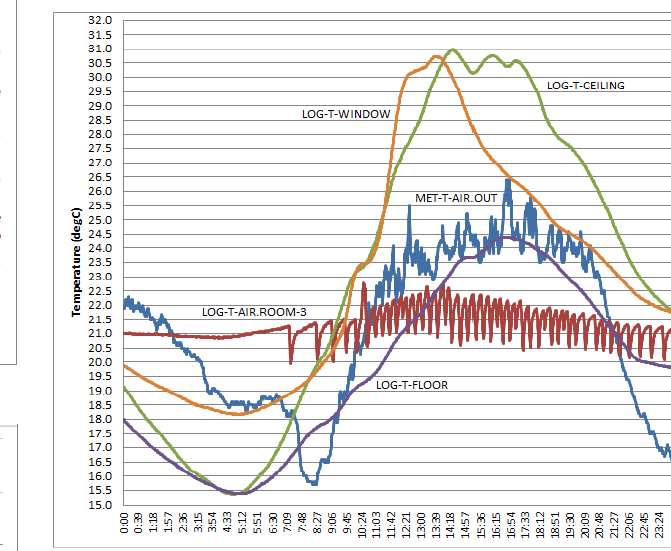
Fig. 14. Temperature of indoor locations.